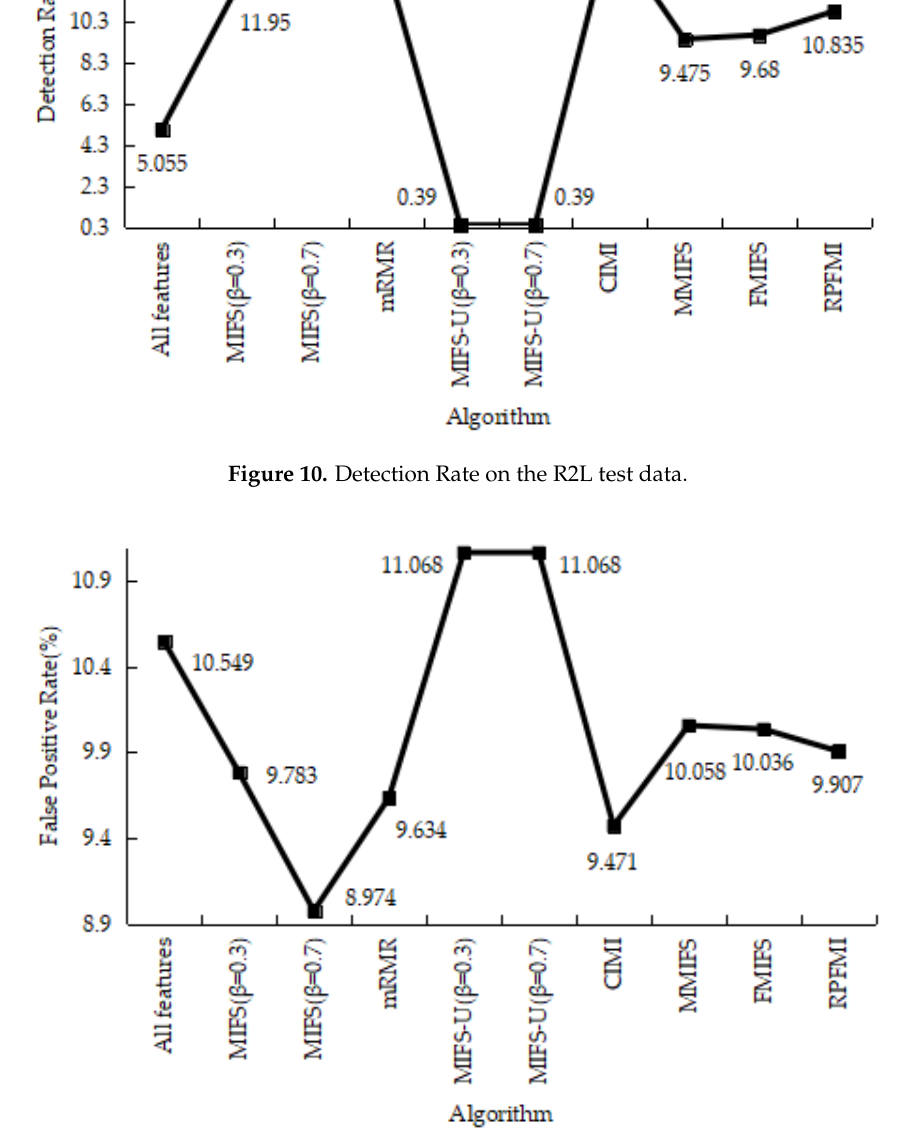
Figure 11. False Positive Rate on the R2L test data.